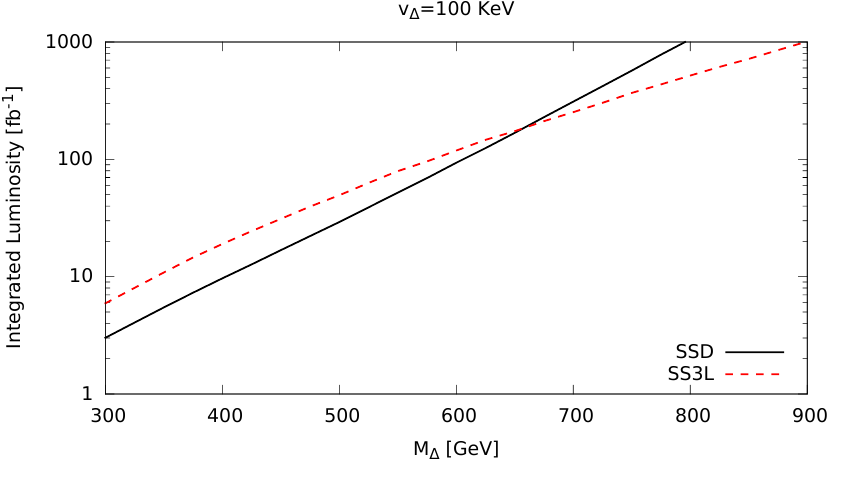
Figure 21 . Required luminosity at the 13 TeV LHC for 5 (cid:27) discovery of quadruplet scalars with large v (cid:1) as a function M (cid:1)